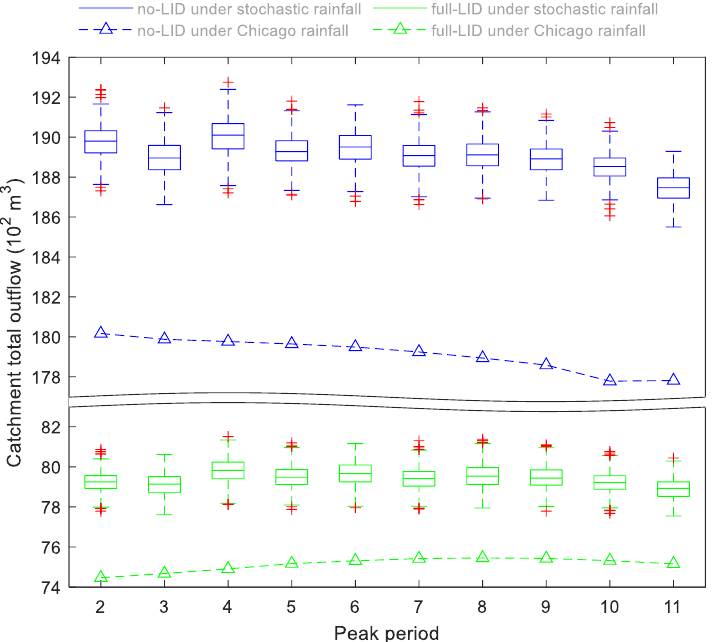
Figure 9. Catchment total outflow in no- and full-LID scenarios under Chicago and stochastic precipitation events. + represents the outlier.